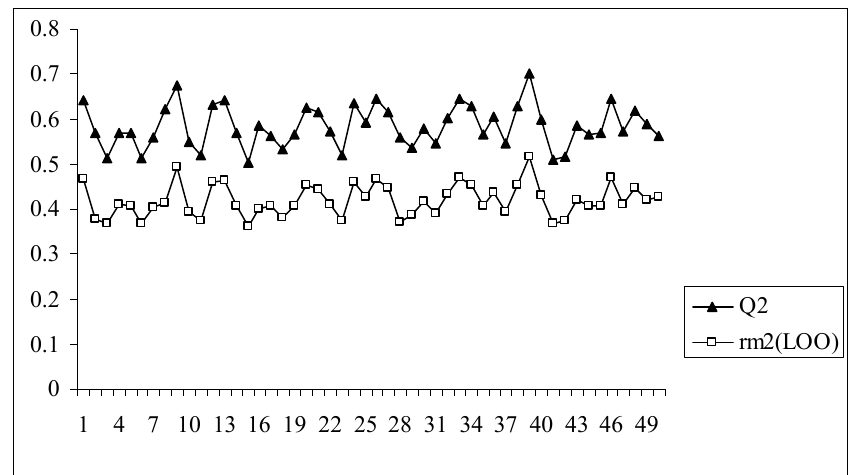
Figure 2. Comparative plots of Q 2 and r m2